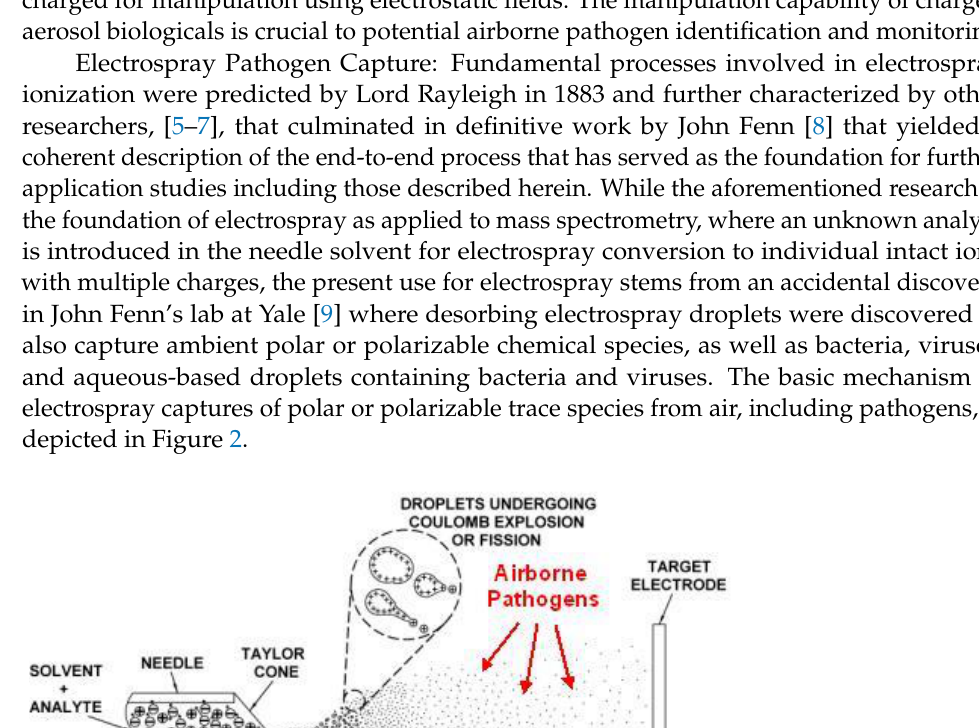
water or an organic